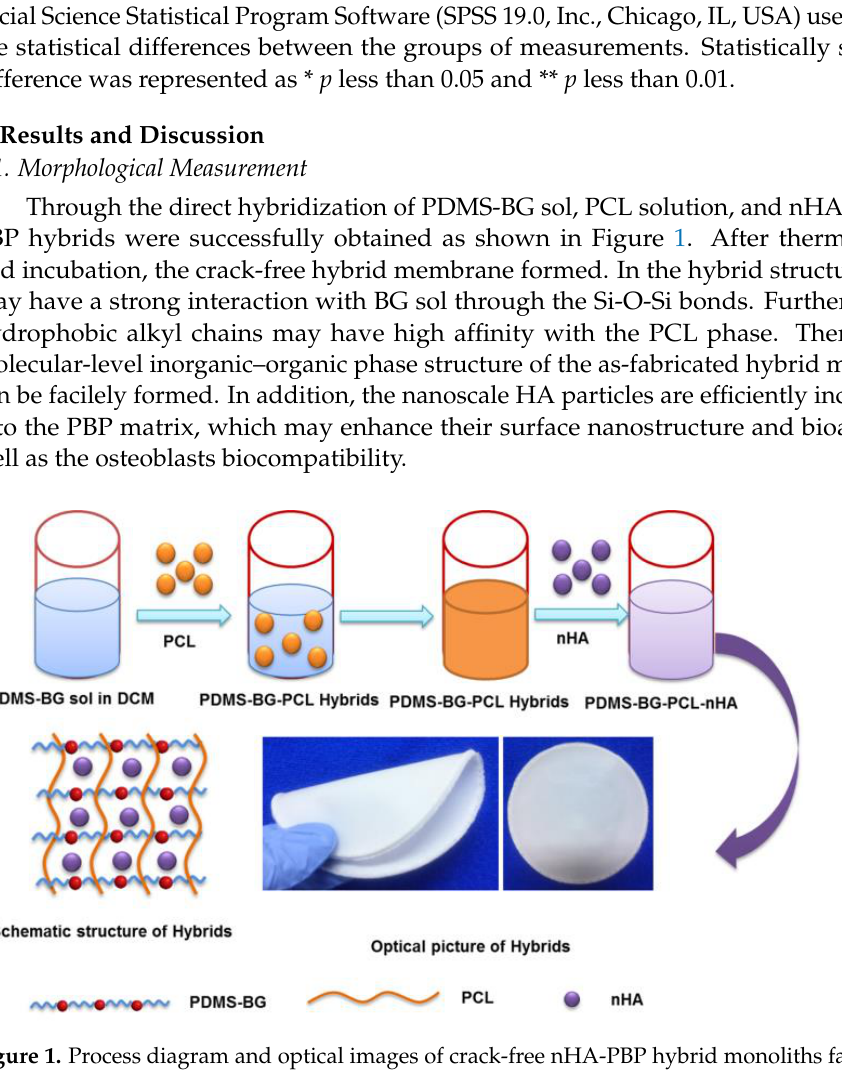
Figure 1. Process diagram and optical images of crack-free nHA-PBP hybrid monoliths fabricated by the representative sol-gel route.